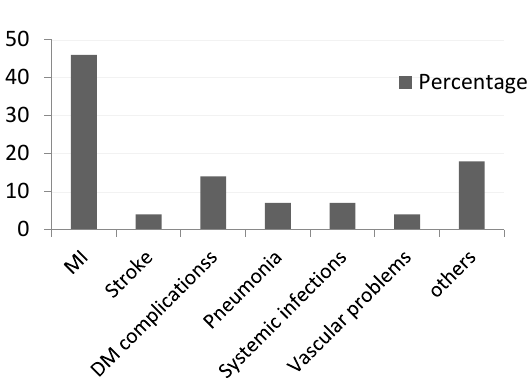
Figure 6. Reasons for